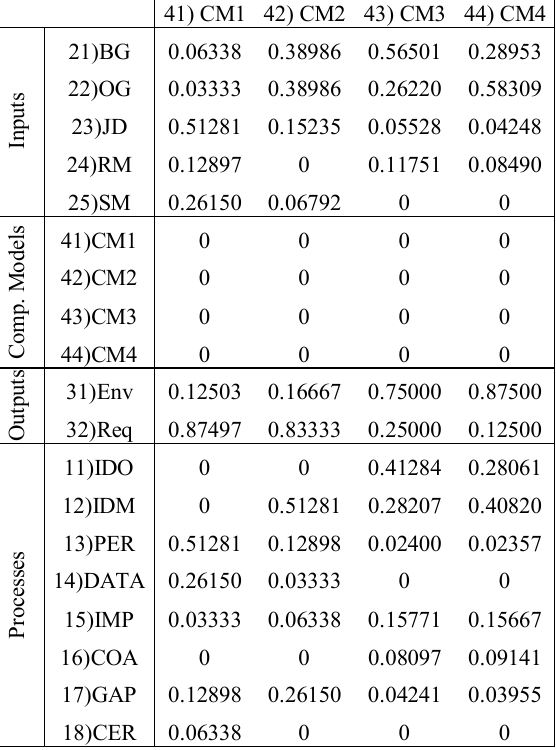
Table 4. A Portion of Unweighted Comparison